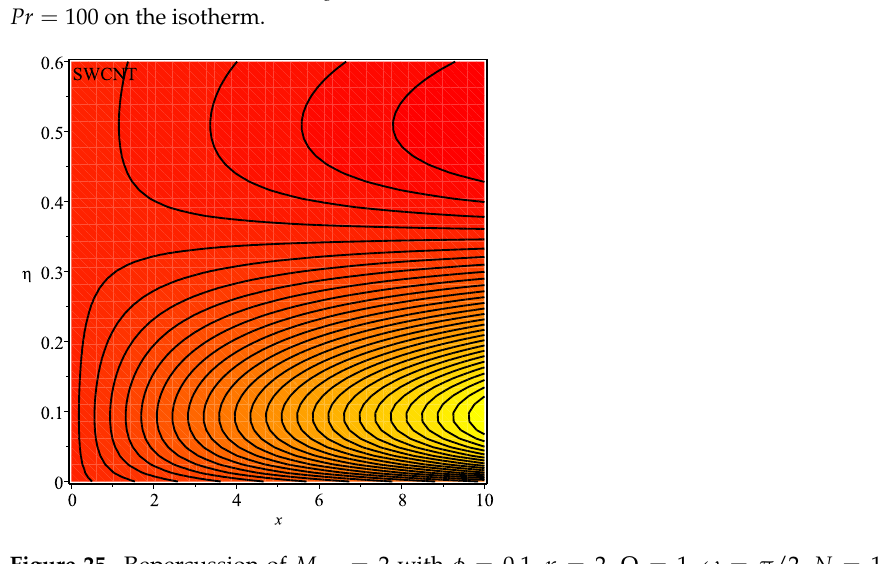
Figure 25. Repercussion of M egt = 2 with φ = 0.1, κ = 2, Ω = 1, ω = π /2, N = 10, Υ = 0.2, Pr = 100 on the isotherm.